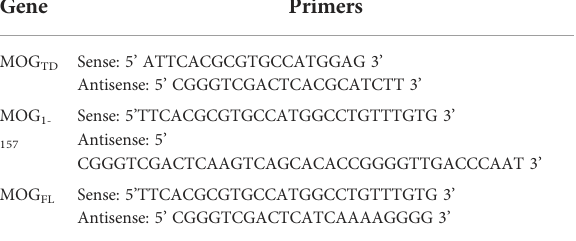
TABLE 4 The sequences of primers used for PCR to amplify MOG.